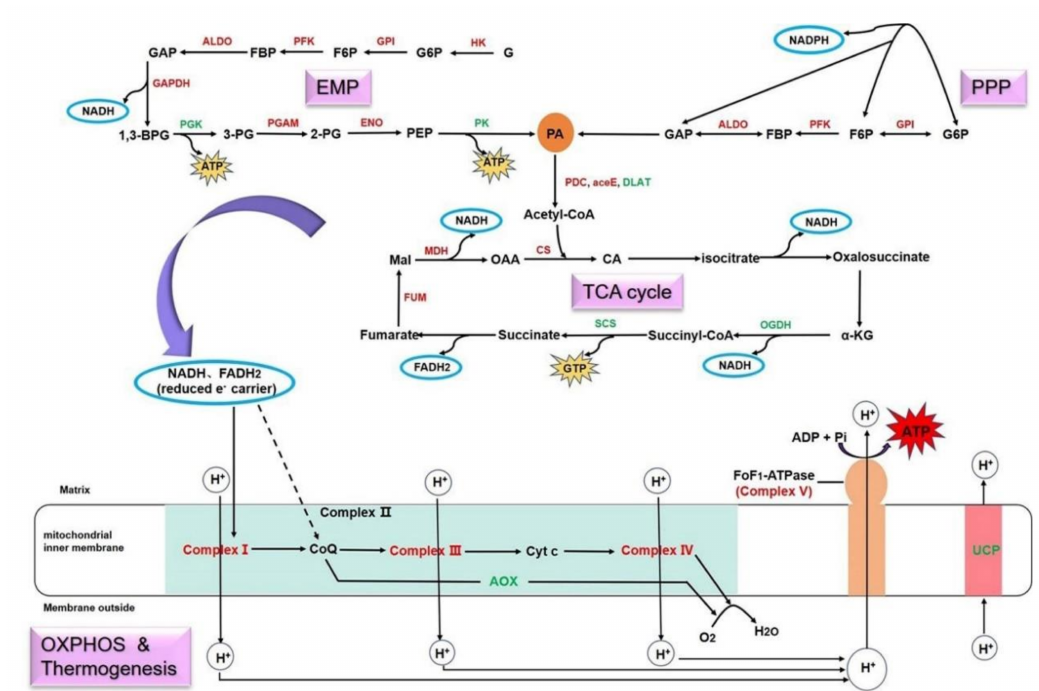
Figure 6. Energy metabolic mechanism for fast-growth initiation in Moso bamboo shoots. The red letters represent upregulated genes and the green letters indicate downregulated genes. Abbrevi- ations: EMP, glycolysis; PPP, pentose phosphate pathway; OXPHOS, oxidative phosphorylation; TCA, tricarboxylic acid; NADH, reduced nicotinamide adenine dinucleotide; FADH2, reduced flavin adenine dinucleotide; ATP, adenosine triphosphate; NADPH, reduced nicotinamide adenine din- ucleotide phosphate; GTP, guanosine triphosphate; ADP, adenosine diphosphate; Pi, phosphate group; G, glucose; HK, hexokinase; GPI, glucose − 6 − phosphate isomerase; PFK, phosphofructkinase; ALDO, fructose-bisphosphate aldolase; PGK, phosphoglycerate kinase; GAPDH, glyceraldehyde phosphate dehydrogenase; ENO, enolase; PGAM, phosphoglycerate mutase; PK, pyruvate kinase; G6P, glucose − 6 − phosphate; F6P, fructose − 6 − phosphate; FBP, fructose − 1,6 − bisphosphatase; GAP, fructose-bisphosphate aldolase; 1,3 − BPG, 1,3 − bisphosphoglycerate; 2 − PG, 2 − phosphoglycerate; 3 − PG, 3 − phosphoglycerate; PEP, phosphoenolpyruvate; PA, pyruvic acid; PDC, pyruvate decarboxy- lase; aceE, pyruvate dehydrogenase E1 component; DLAT, pyruvate dehydrogenase E2 component; CS, citrate synthase; CA, citric acid; α -KG, α -ketoglutarate; SCS, succinyl-CoA synthetase; OGDH, oxoglutarate dehydrogenase; fum, fumarase; Mal, malate; MDH, malate dehydrogenase; OAA, oxaloacetic acid; Complex I, NADH dehydrogenase; Complex II, succinate dehydrogenase; Com- plex III, cytochrome reductase; Complex IV, cytochrome oxidase; Complex V, ATP synthase; CoQ, coenzyme-Q; Cyt c, cytochrome c; AOX, alternate oxidase; UCP, uncoupled protein; H + , proton; O2, oxygen; H2O,